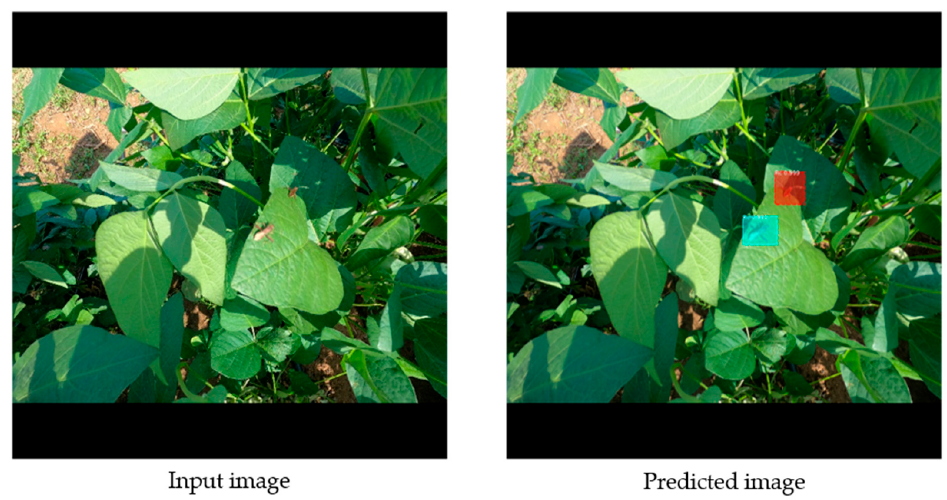
Figure 6. Prediction of object detection. In prediction, which is the result of neural network learning using the original image, the class of R. pedestris can be detected through classification and localization and the positions of objects are displayed as in the picture on the right.